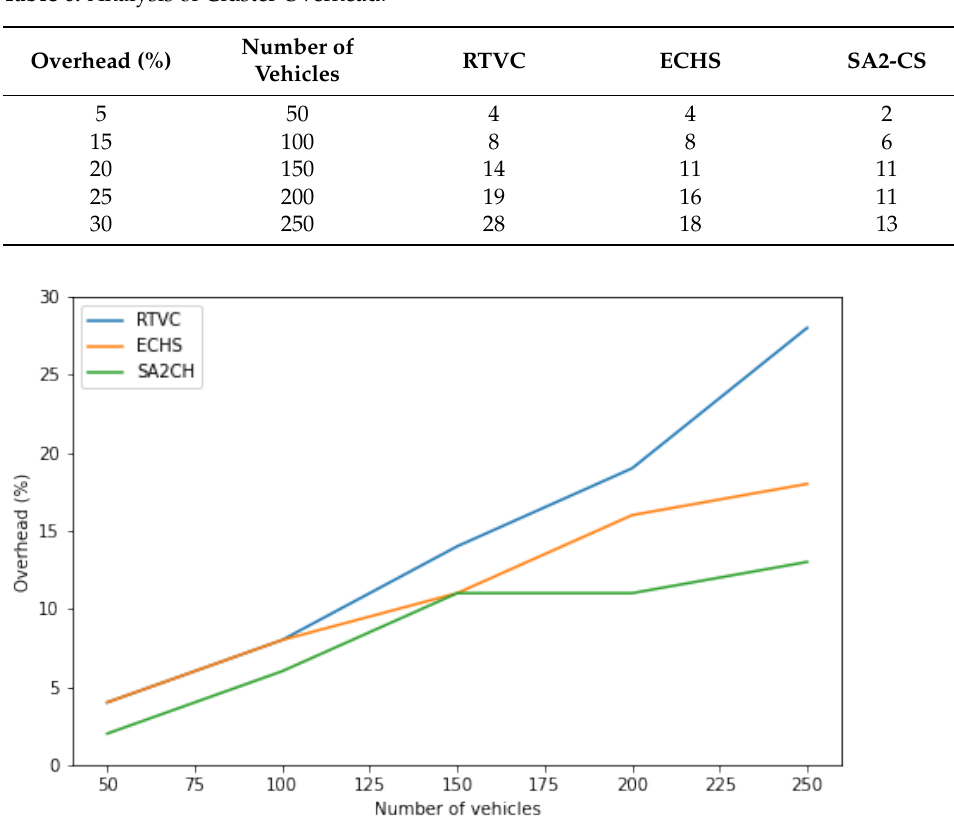
Figure 11. Comparative graph of CO between the existing and proposed technique